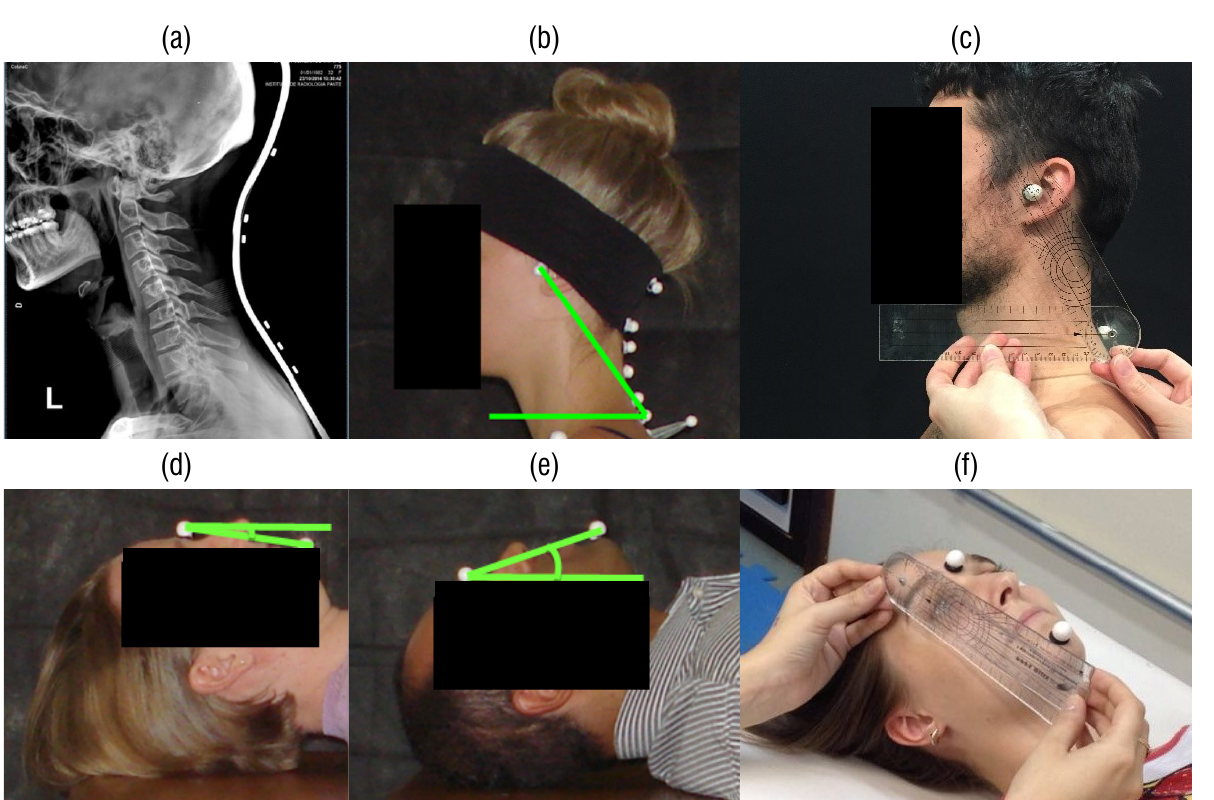
Figure 1 – Analysis of head position and analysis of cervical curvature: (a) Angle of head position using X-ray examination; (b) Angle of head position using photogrammetry; (c) Angle of head position using goniometry; (d) Angle of cervical curvature using the TFMLI indicating a decrease in cervical curvature; (e) Angle of cervical curvature using the TFMLI indicating an increase in cervical curvature and (f) Angle of cervical curvature using the TFMLI with a